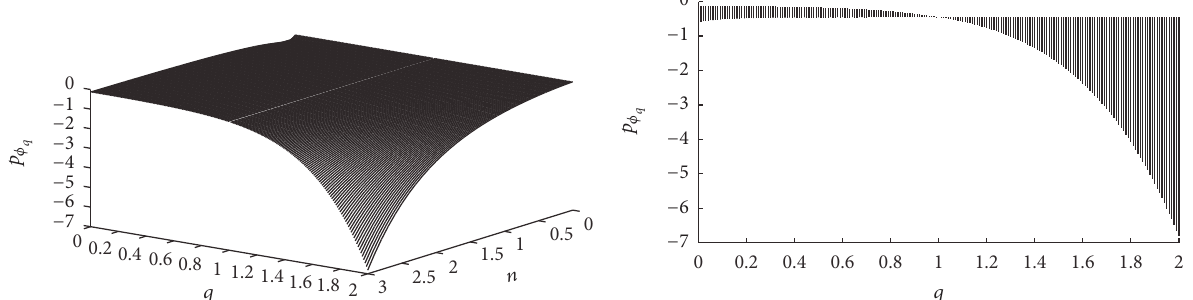
Figure 9: Effect of 𝑞 on the accelerated expansion behavior with negative dark energy